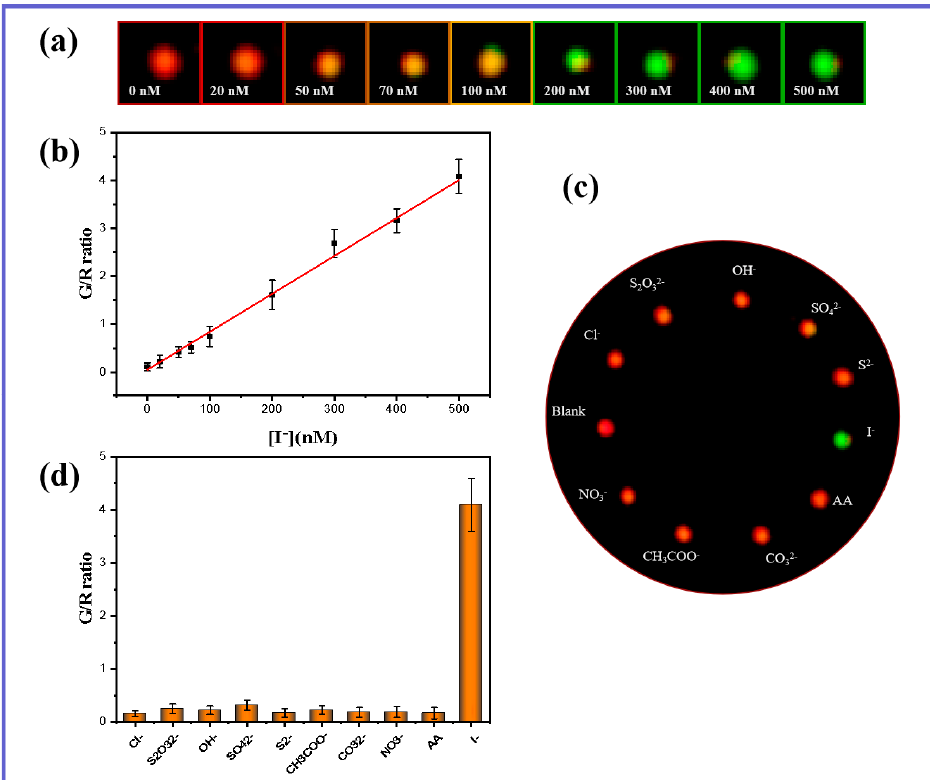
Figure 4. ( a ) Scattering images of GNSs in the presence of iodide within the concentration range of 0–500 nM. ( b ) G/R ratio vs. iodide concentration. ( c ) Images and ( d ) G/R ratio of GNSs with an exposure of 0.5 µM of other anions, including Cl − , S 2 O 32 − , OH − , SO 42 − , S 2 − , CH 3 COO − , CO 32 − , NO 3 − , and AA.